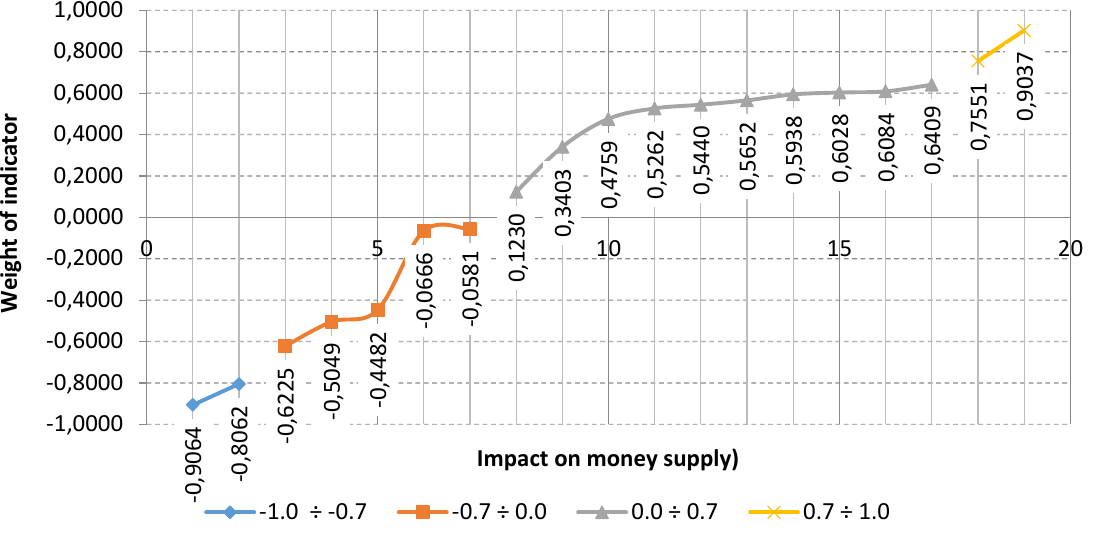
Figure 1. Grouping of the national economy indicators of Ukraine according to the impact on the money